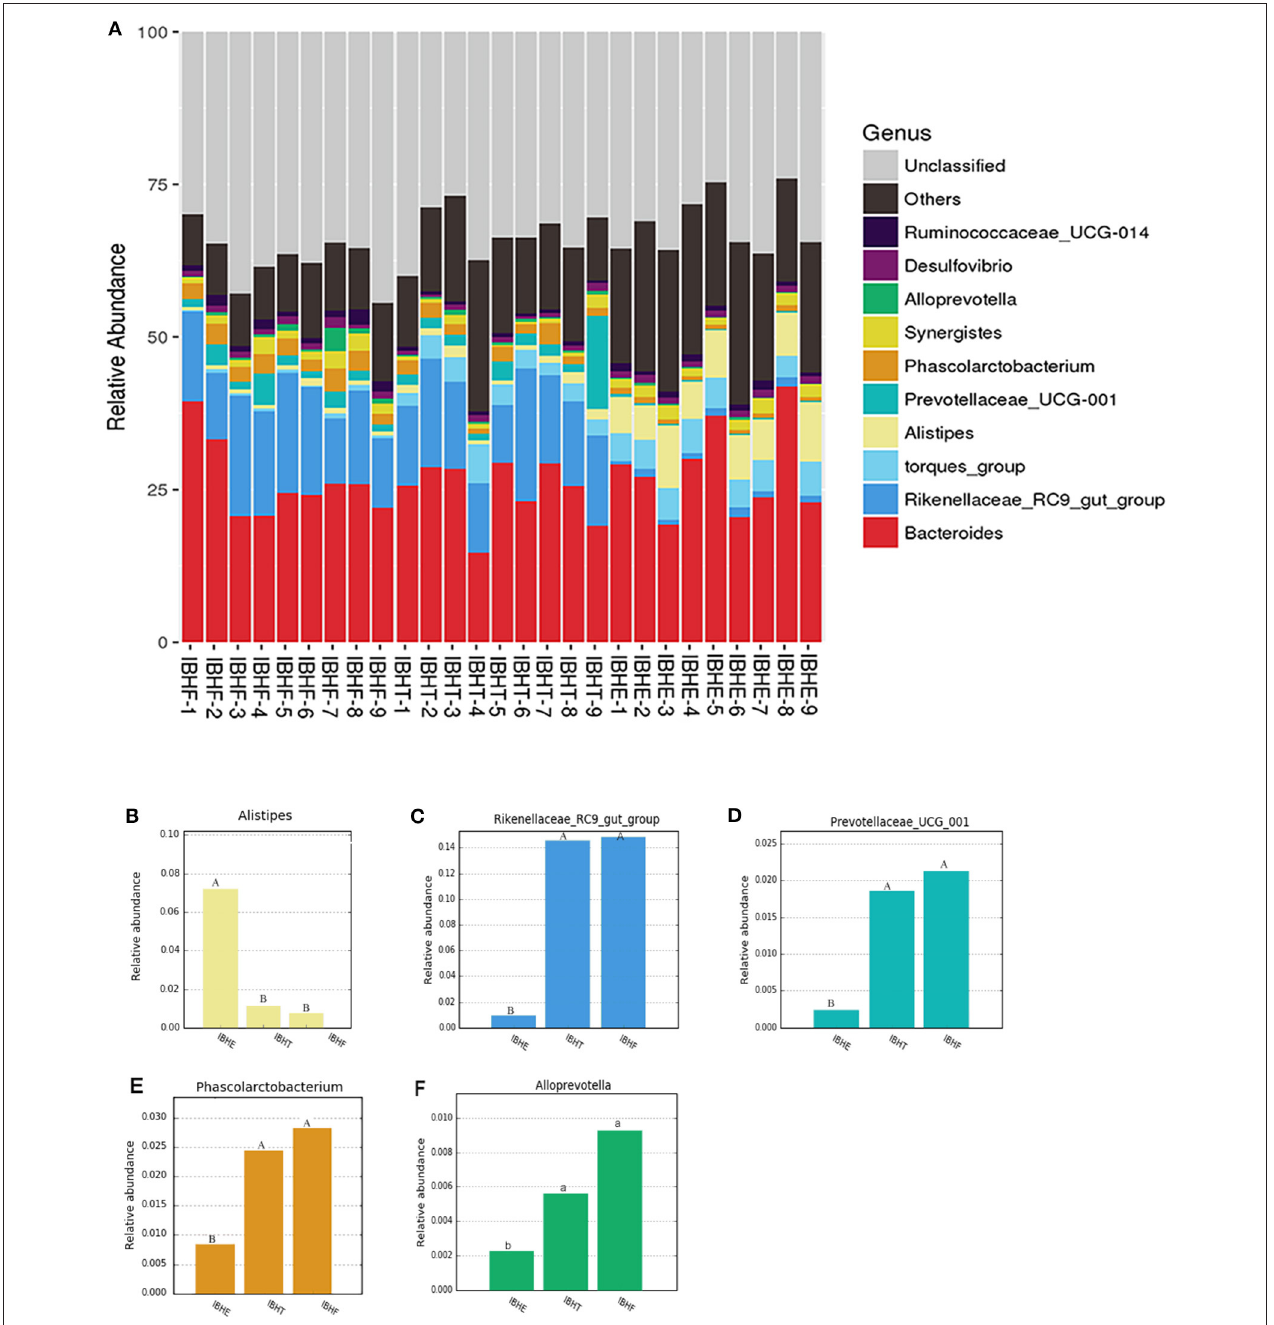
FIGURE 4 | Taxonomy stack distribution and abundance histograms of the dominant bacteria genera of chickens in different growth periods. (A) Taxonomy stack distribution of the dominant genera at 8, 20, and 50 weeks. IBHE, IBHT, and IBHF refer to “ISA Brown Hens-8 weeks,” “ISA Brown Hens-20 weeks,” and “ISA Brown Hens-50 weeks,” respectively. The top 10 dominant bacteria genera during different periods were classified. A distinctive color histogram represents the relative distribution of these most dominant bacteria. The names of distinct levels of genera are shown on the right of the figures, and the names of the samples are under the figure. (B–F) Abundance histograms of some significant dominant genera at 8, 20, and 50 weeks. Genera with different superscript letters mean significant differences ( P < 0.05) between groups, and different superscript letters mean extremely significant differences ( P < 0.01).